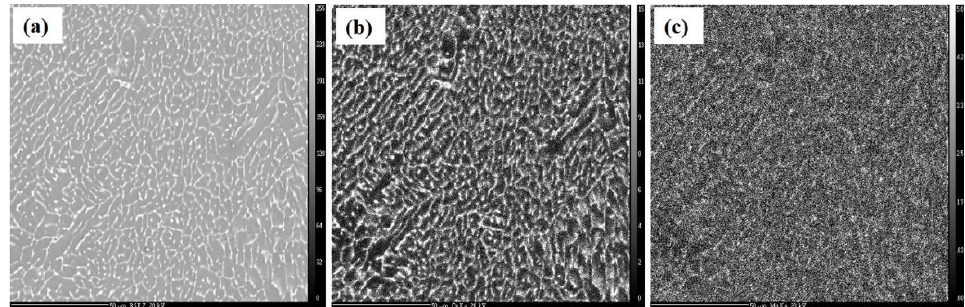
Figure 11. ( a ) Backscattered electron micrograph of FZ; ( b , c ) backscattered electron micrographs indicating elemental mapping of Cu and Mg in FZ, respectively.